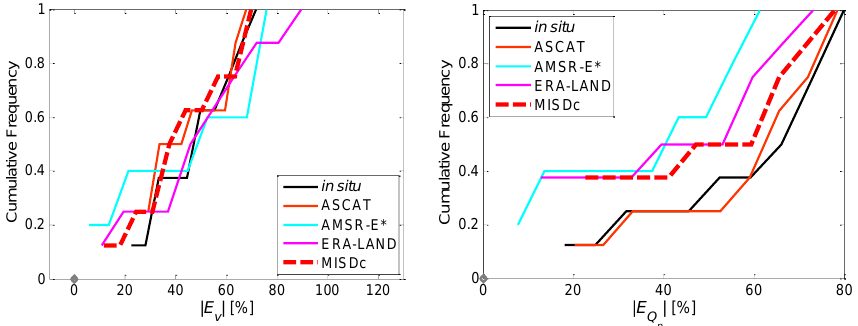
| (b) . (a) was obtained from p